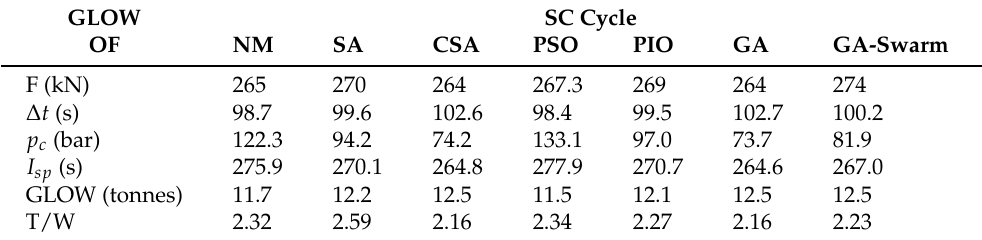
Table 13. SC Cycle: Values of Variables at max I sp for each technique. I sp OF